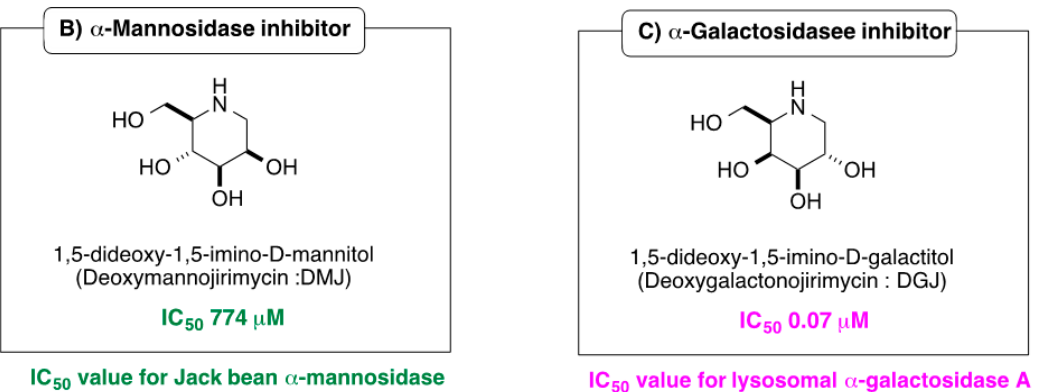
Figure 1. Structures and glycosidase inhibition of piperidine and pyrrolidine iminosugars, and acarbose. ( A ): α -glucosidase inhibitors. ( B ): α -mannosidase inhibitor. ( C ): α -galactosidase inhibitor.